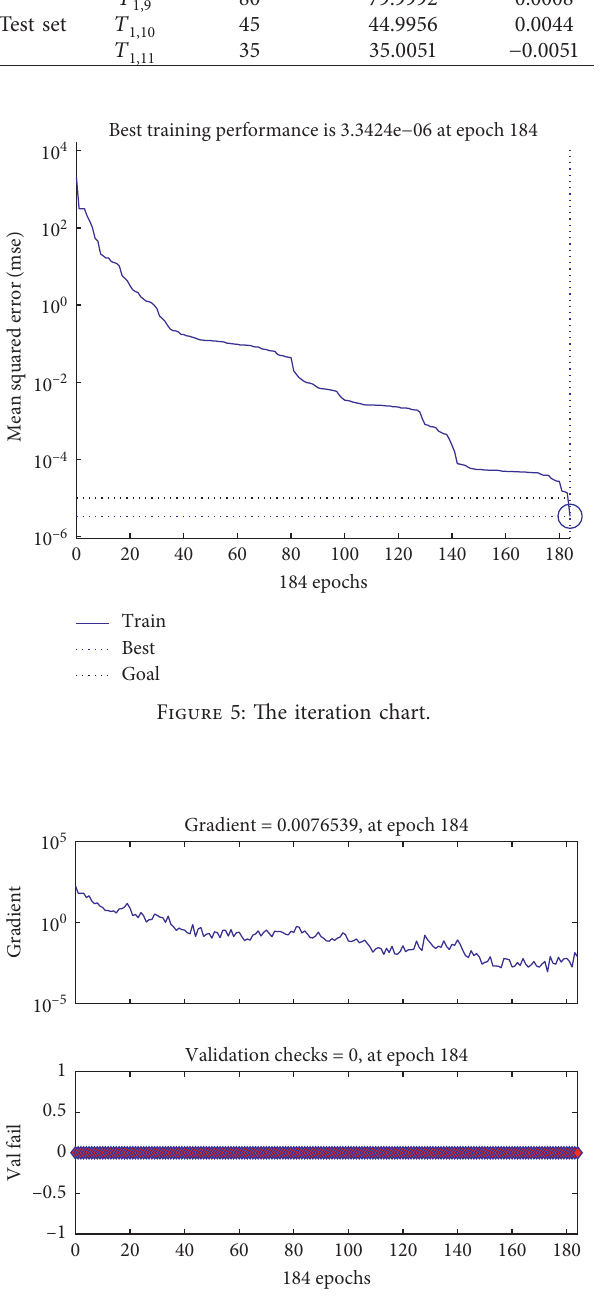
Figure 6: The training